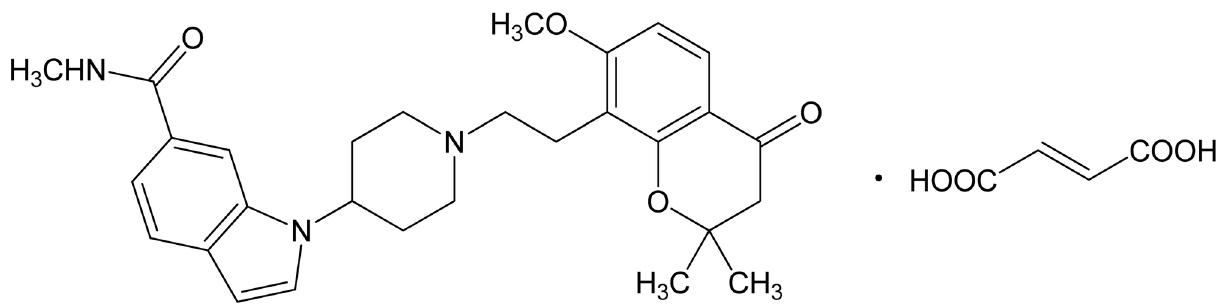
Figure 1. Chemical structure of